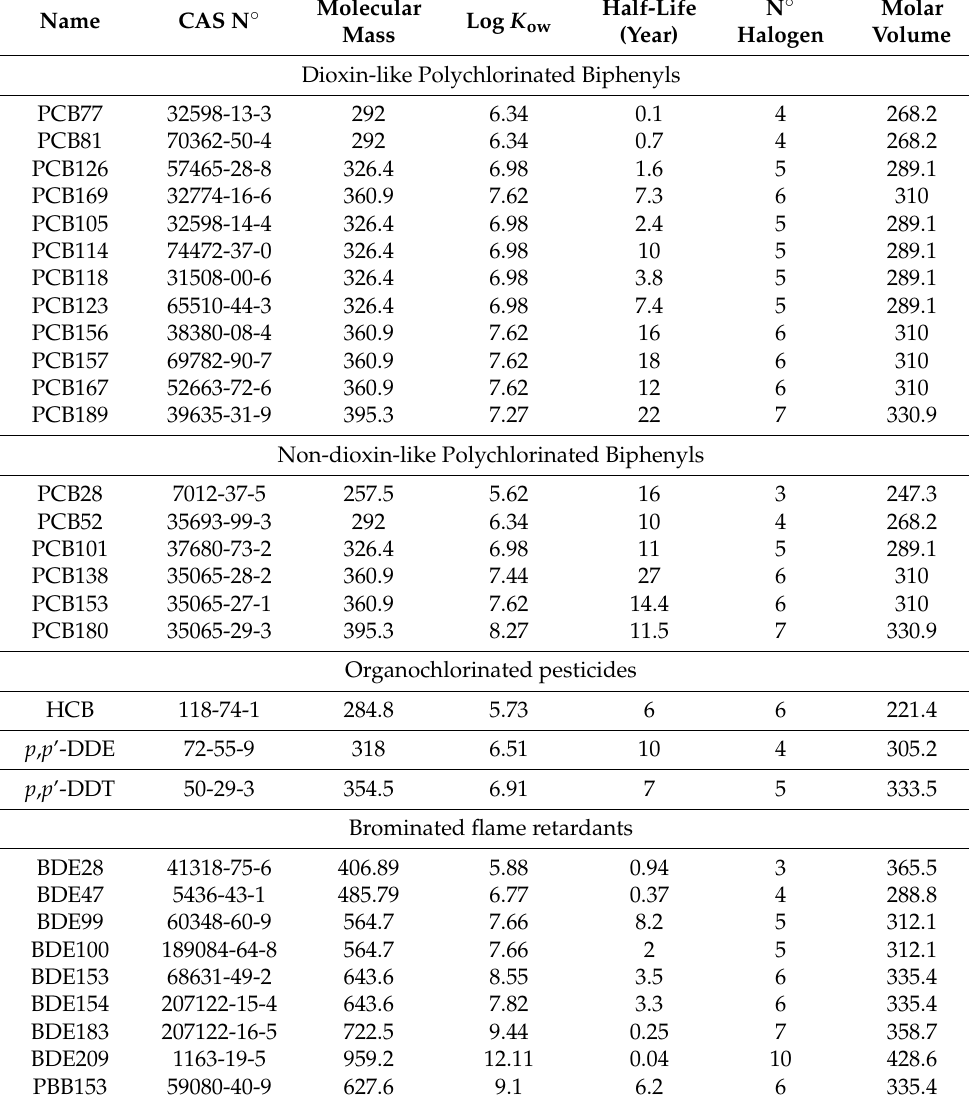
Table 2. Physicochemical properties of included chemicals retrieved from PUBCHEM database [39] and adapted from previous publications